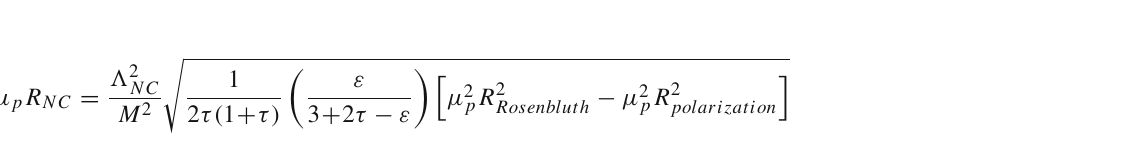
Fig. 2 TheratioofelectricandmagneticformfactorinRosenbluthand polarization methods. By slight changing the scattering angle around ϕ ∼ 180 ◦ the μ p R NC would reproduce the green region. The experi- mental data in Rosenbluth and polarization methods are quoted respec- tively from [13,14,45,46] and [9,10,48–51]